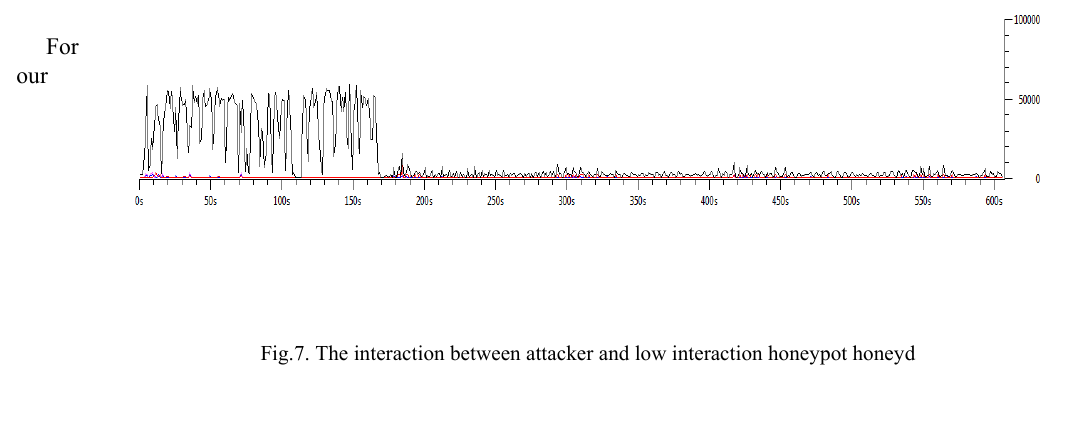
Fig.7. The interaction between attacker and low interaction honeypot